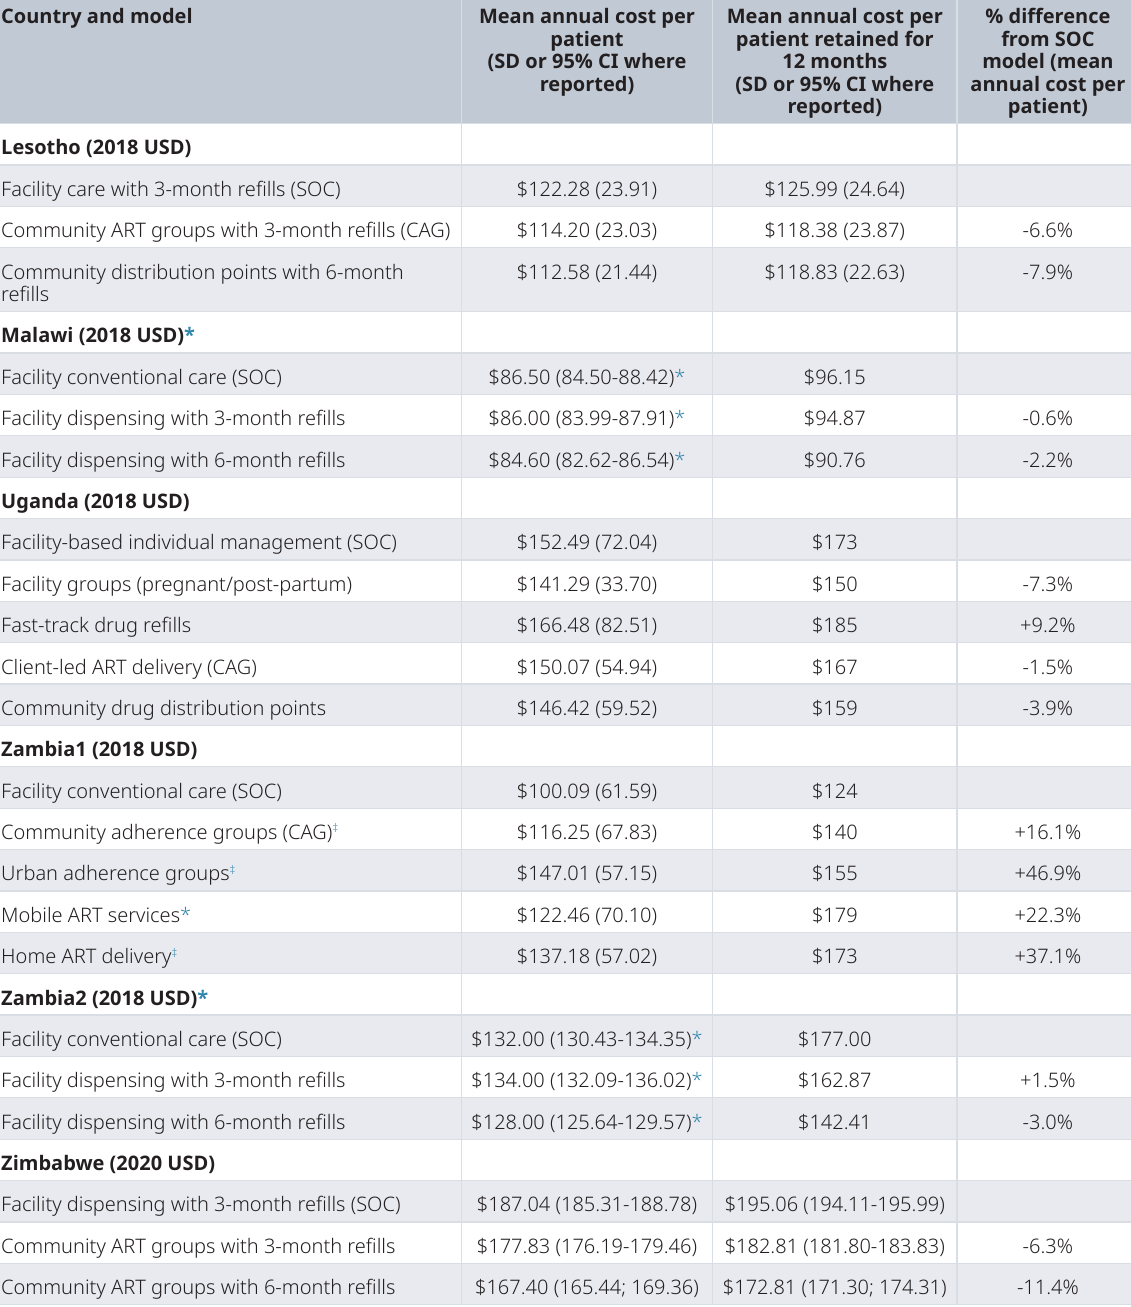
Table 3. Average annual cost and cost per patient retained at 12 months, by country and model, in